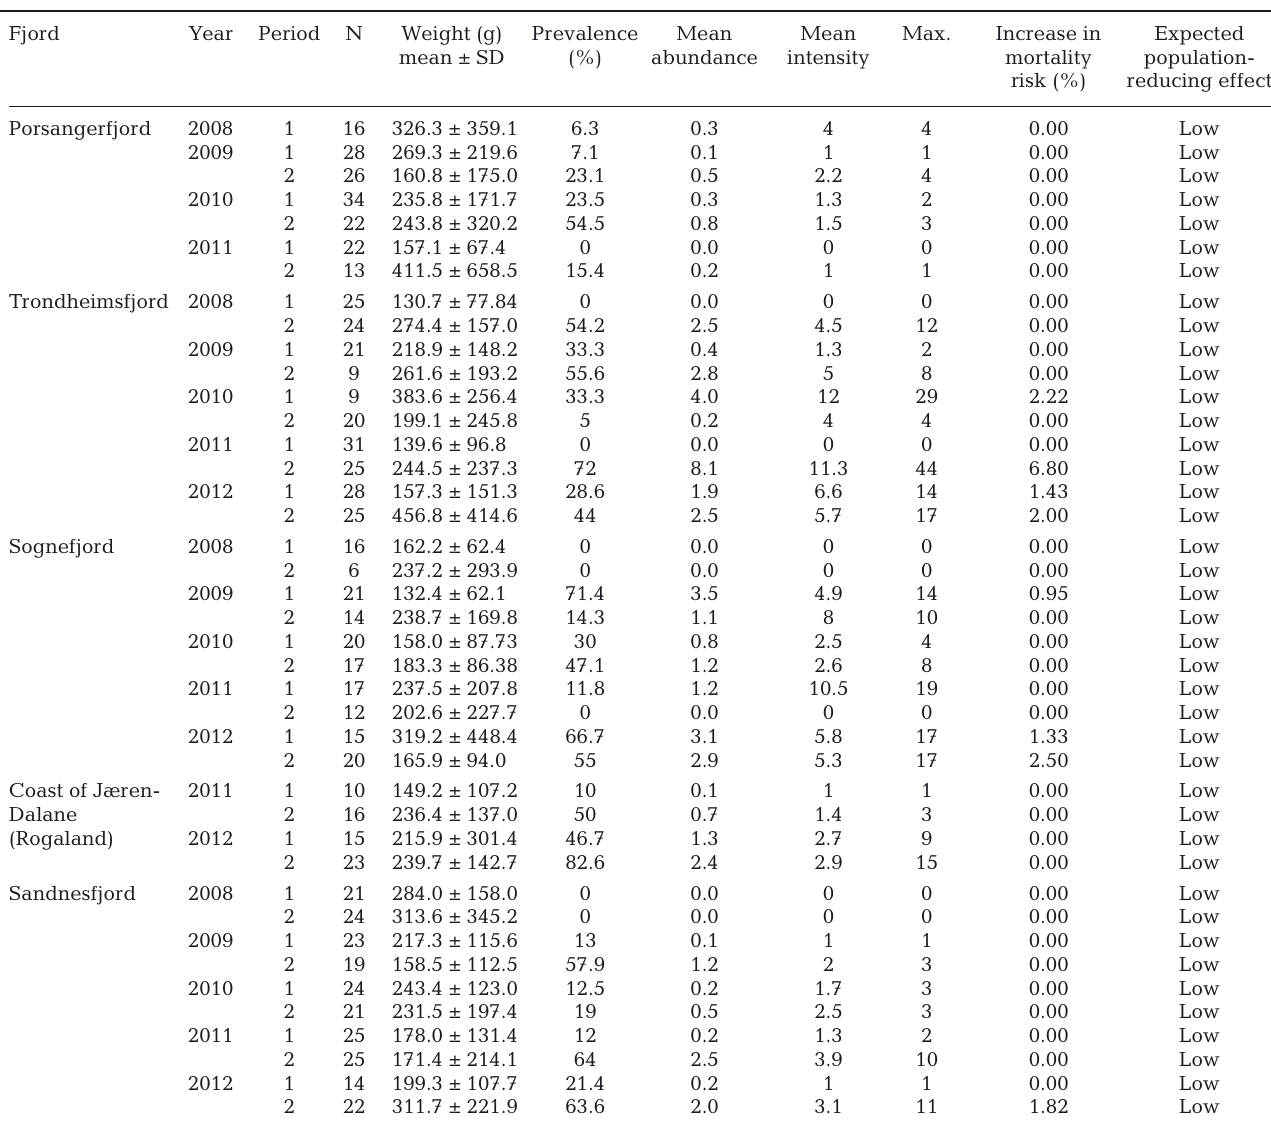
Table 2. Salmon lice infection parameters for sea trout caught inside large National Salmon Fjords (i.e. >30 km from the closest fish farm- ing site) in the period 2008 to 2012 (from north to south). Period: 1 (May to June), 2 (June to August); prevalence: percentage of fish in- fected in the sample; mean abundance: average number of salmon lice in all sampled fish; mean intensity: average number of salmon lice in infected fish; max.: maximum number of lice recorded on a fish; increase in mortality risk: percentage of the sample estimated to suffer an increase in mortality risk due to sea lice according to Taranger et al. (2012); expected population-reducing effects: classified as ‘low’, ‘medium,’ and ‘high’ according to the percentage of fish in the sample expected to suffer an increase in mortality risk, according